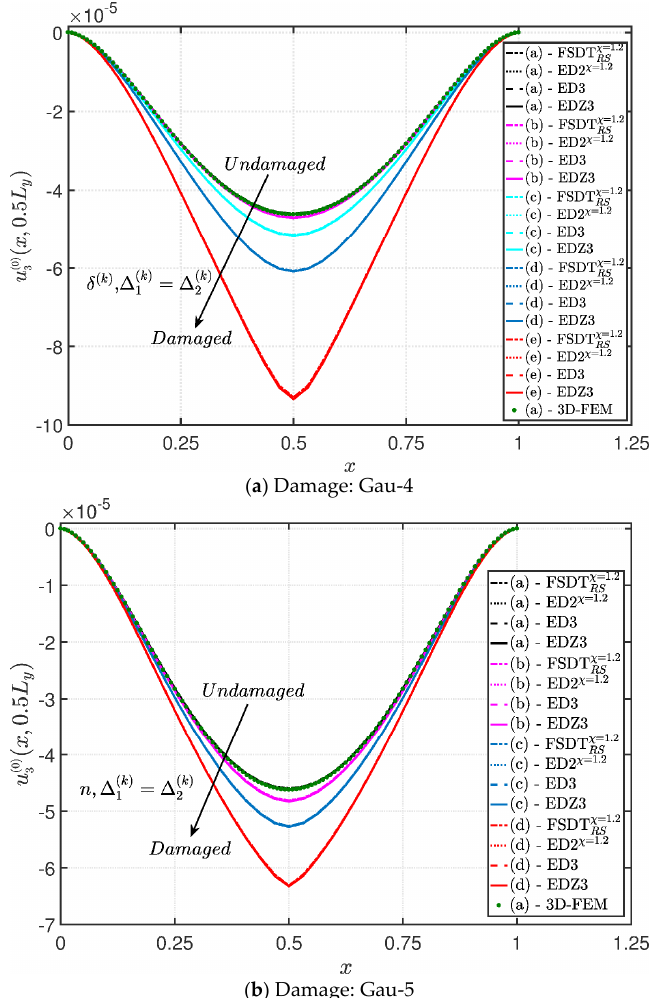
Figure 13. Evaluation of the central vertical displacement profile [m] for the CCCC laminated square plate varying the mechanical parameters of the damage: ( a ) Gau-4; ( b ) Gau-5. The results are obtained by means of several HSDTs.